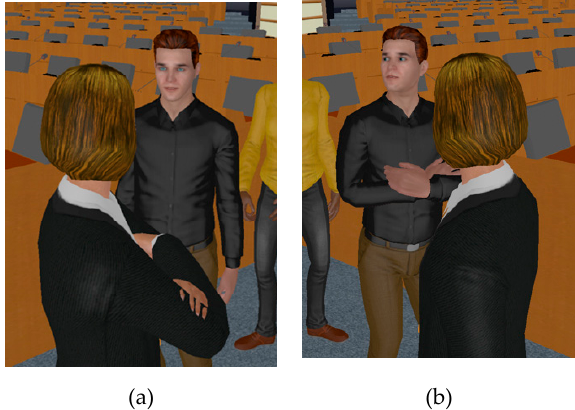
Figure 7. ( a ) A user engaged with the ECA (right side) and ( b ) the same user not engaged with the ECA (left side).